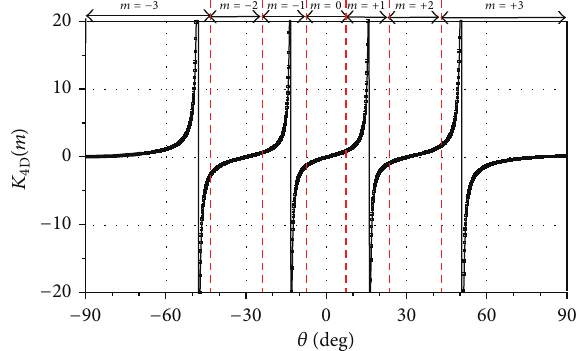
of the 4D array where isotropic D